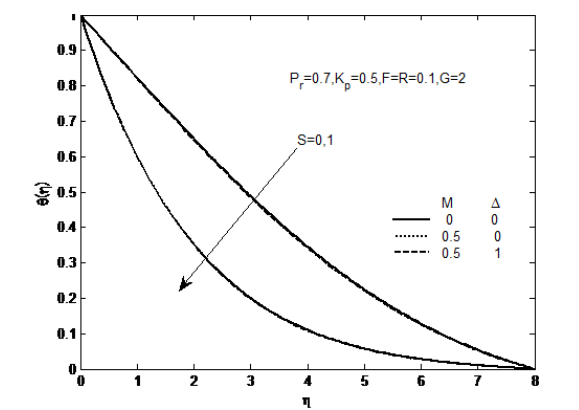
Fig. 8: Temperature profile for different values of S , ∆ and M